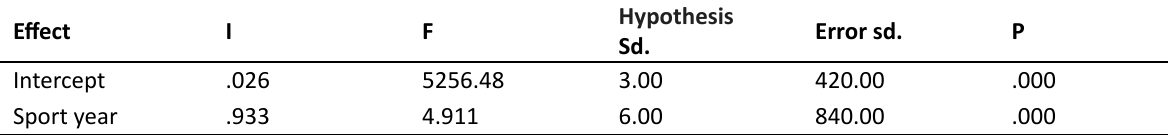
Table 3. Results of moral decision-making attitudes of athletes according to sports year (sports year, mean, standard